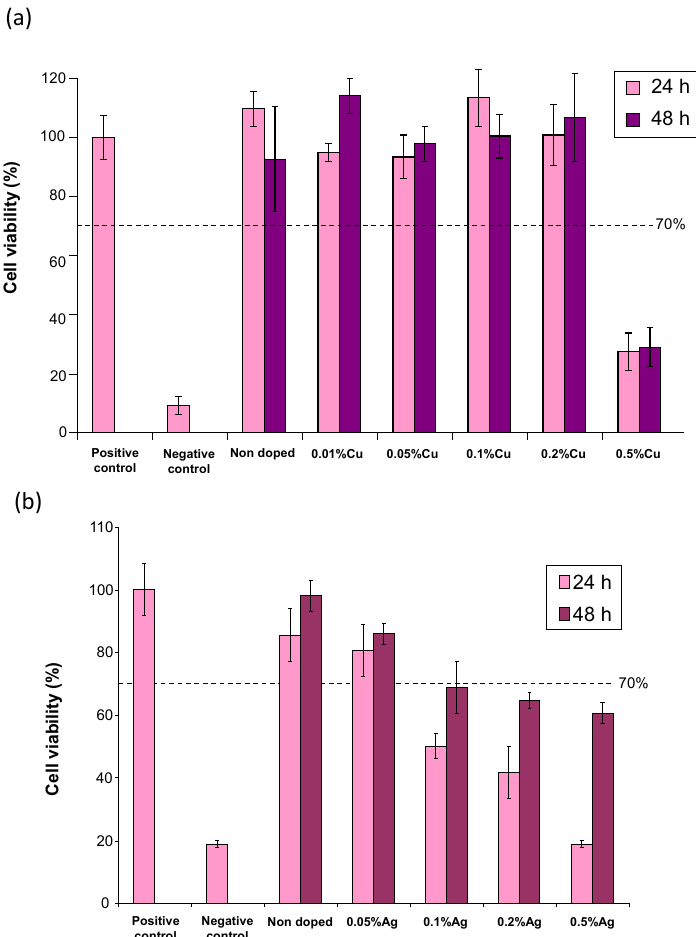
Figure 7. Cytotoxicity evaluation (CAL-72 human osteoblast cells) via the Neutral Red assay of pre-equilibrated hap-1d pelletized samples, non-doped (reference), or doped with either Cu 2+ ( a ) or Ag + ( b ) ions (percentages refer to the substitution of calcium in the precipitation medium) in our working conditions, relative to the controls. The cell viability % is provided with reference to the positive control set to 100%.